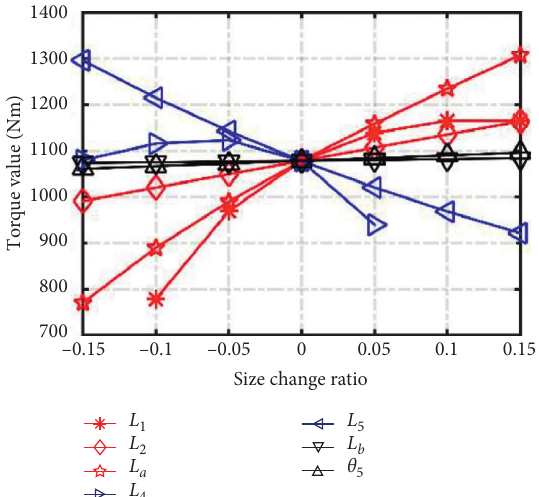
Figure 18: Torque values to meet the static contact force 70N and the designed height